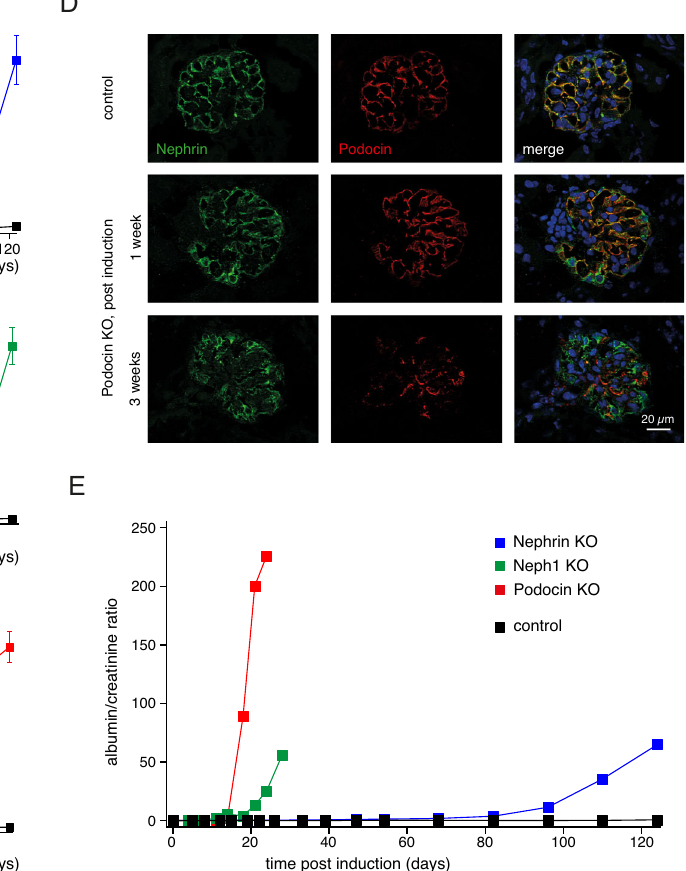
determinedwithanti-Nephrin(green)andanti-Podocin(red)ABsbeforeandatthe indicated periods after doxycycline-triggered knockout of Podocin in mouse glo- meruli.Blue color originates from DAPI staining. Scaling asindicated;experiments were repeated three times with similar results. E Albuminuria quanti fi ed as albu- min/creatinine ratio as a function of time after induction of the target-gene knockout. Data points are the mean values shown in (A)-(C). Note the largely dif- ferent development of albuminuria after induction of the targeted